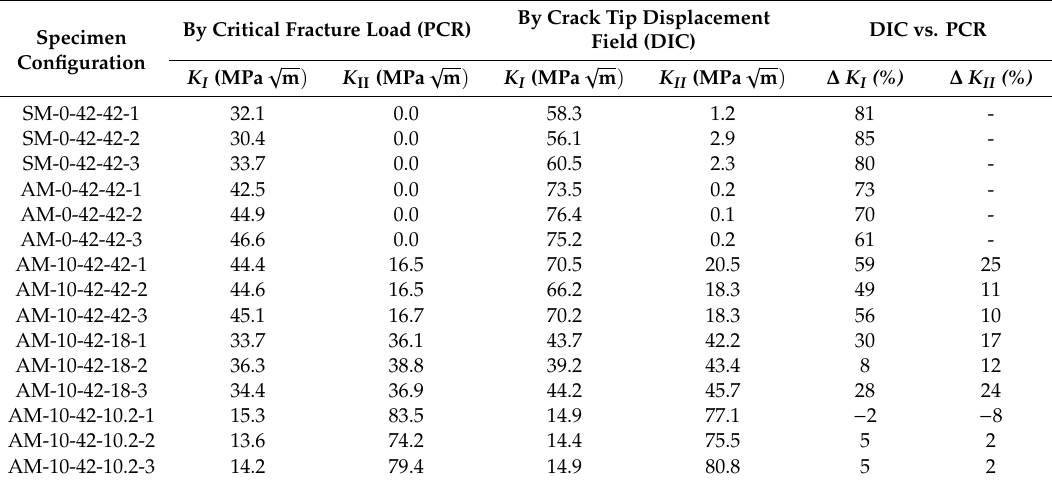
Table 3. Values of the SIFs obtained by critical fracture load and by fitting the displacement field. Specimen Configuration